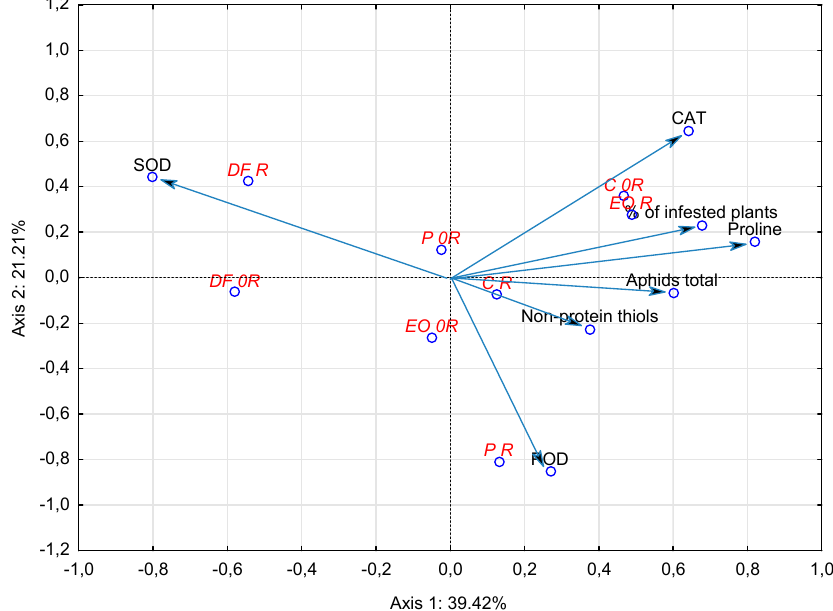
Figure 5. Principal component analysis of Aphis fabae occurrence, biochemical parameters and soil contamination with PDSs. Symbols as in Figure 1.